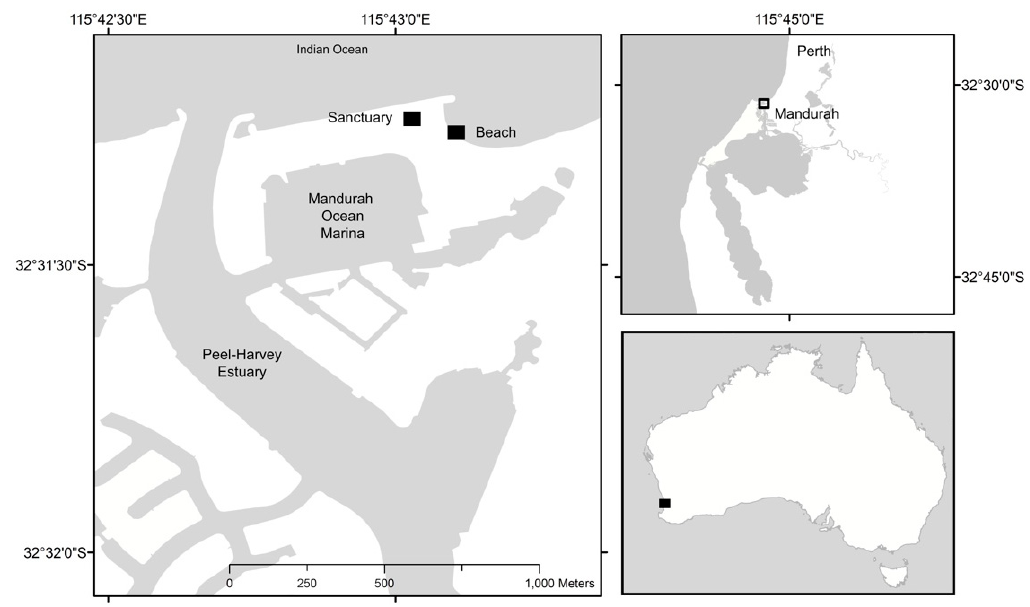
Figure 1. Map showing the location of the Fairy Tern, Sternula nereis nereis , sanctuary and beach colonies established in Mandurah, Western Australia during the 2018 breeding season (October to December).